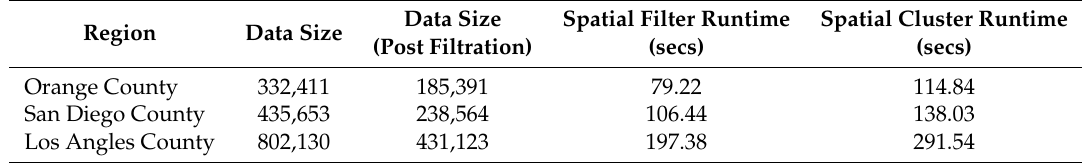
Table 1. Running time of algorithm with comparable property count for all